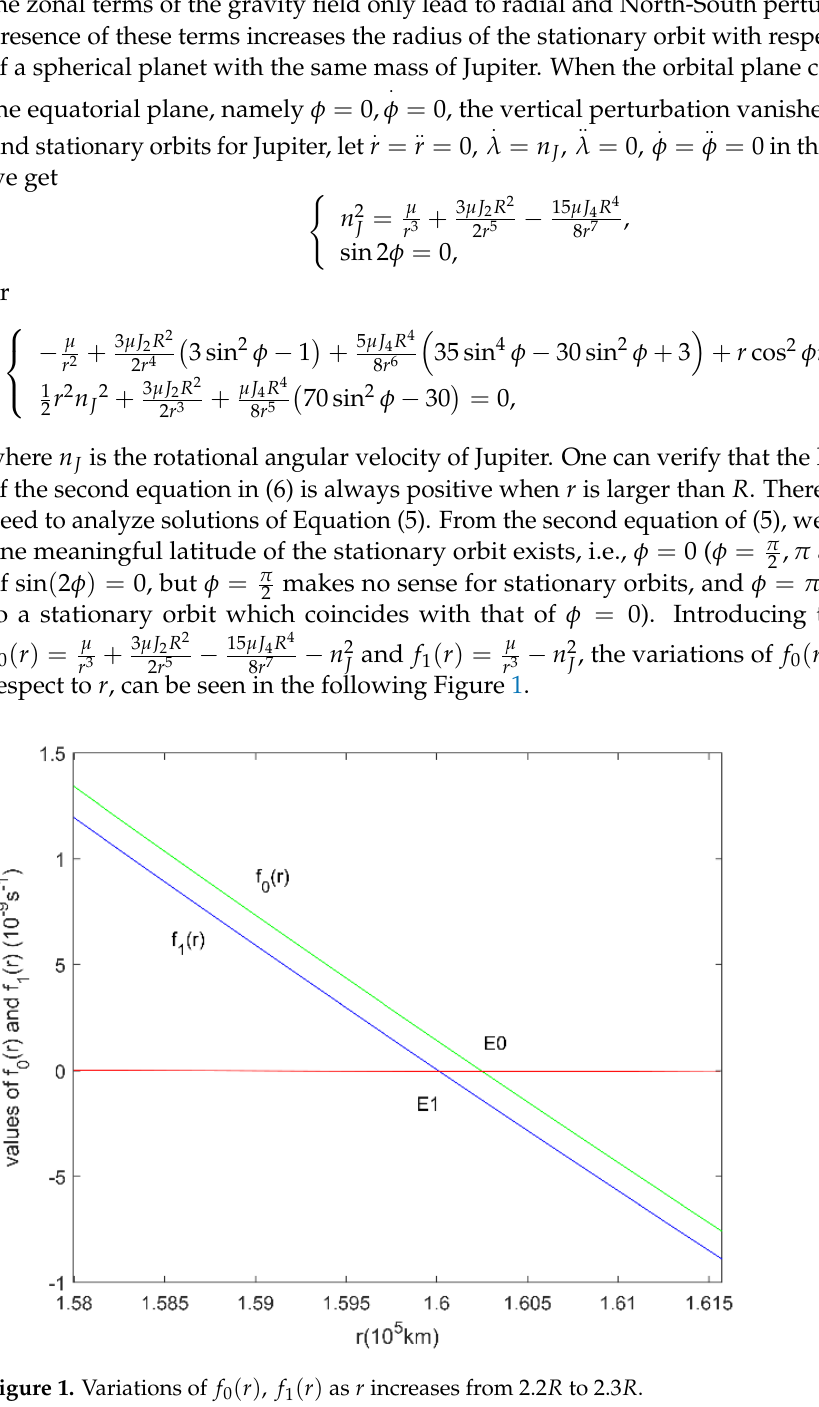
Figure 1. Variations of